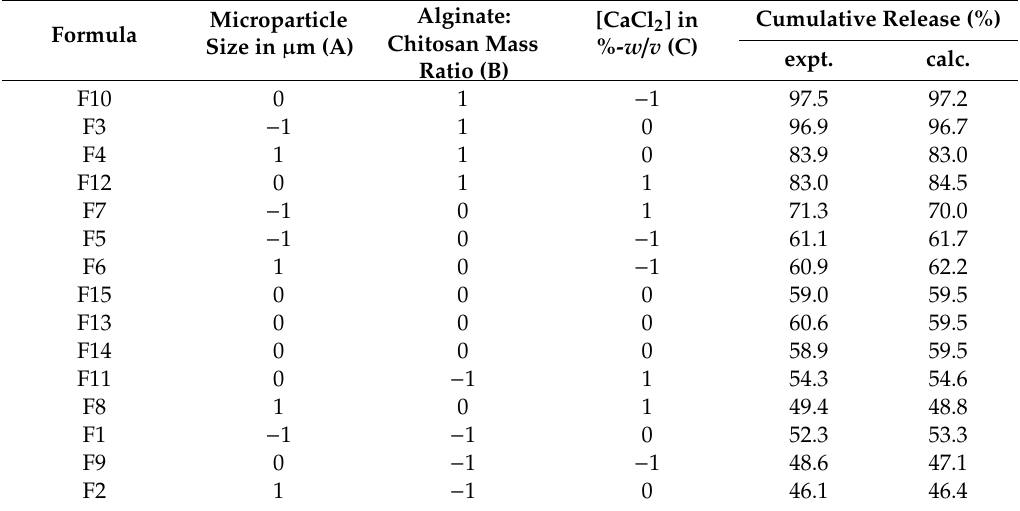
Table 2. Microparticle formula, coded level, and mangostin cumulative release at 10